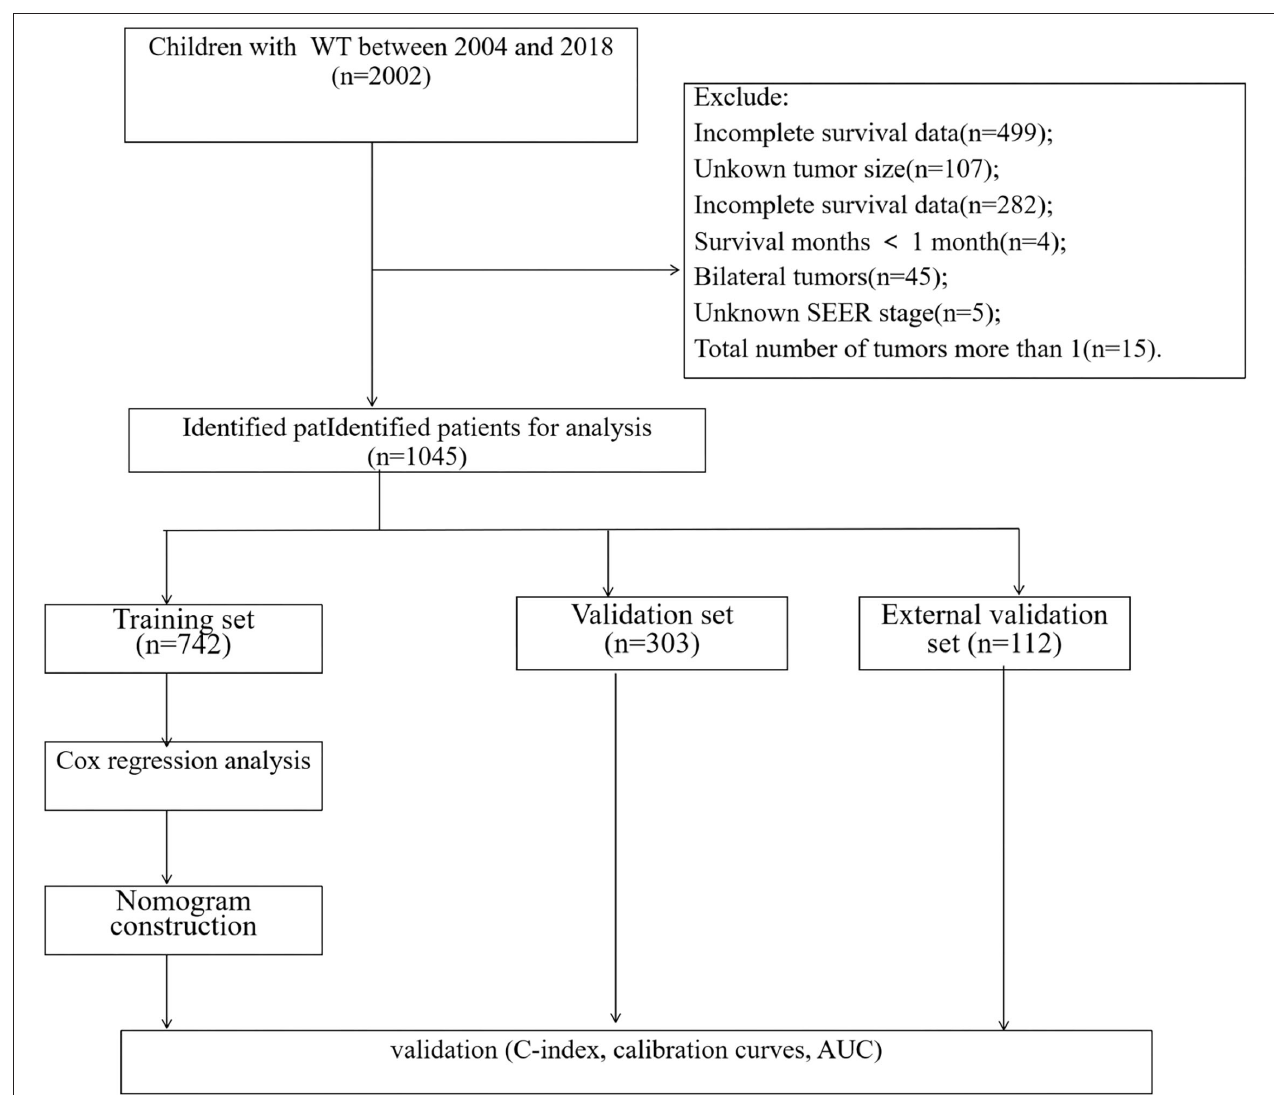
FIGURE 1 | The flowchart of including and dividing